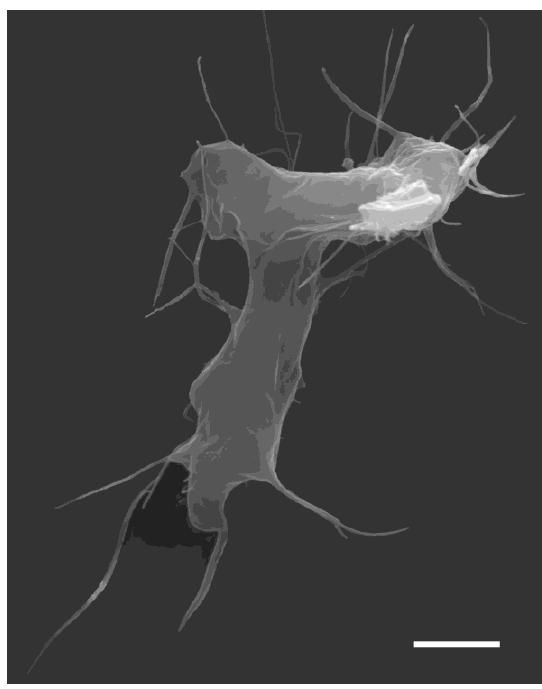
FIGURE 1. Scanning electron micrograph of a single IC isolated from guinea pig small mesenteric arteries. Scale bar: 5